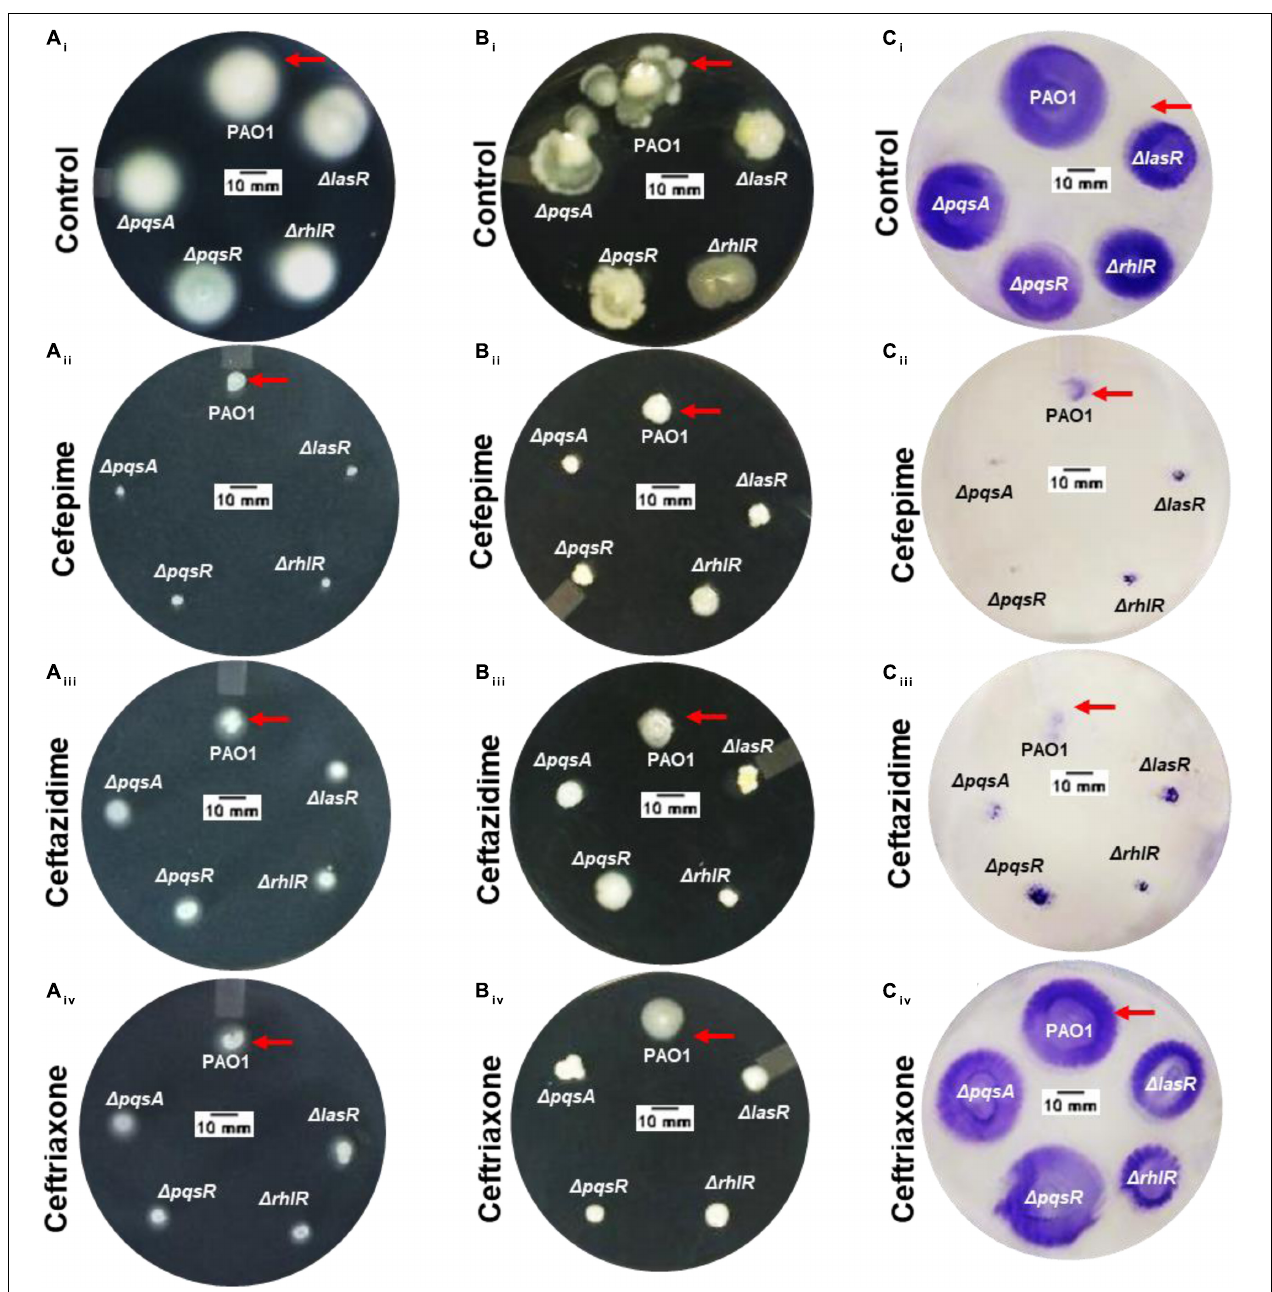
FIGURE 3 | Effect of cephalosporins on motility phenotypes of Pseudomonas aeruginosa PAO1 and its isogenic QS mutant strains. Image showing the comparative zone of swimming (A i ) , swarming (B i ) , and twitching motility (C i ) of PAO1 and its isogenic QS mutant strains ( (cid:49) lasR, (cid:49) rhlR, (cid:49) pqsA, and (cid:49) pqsR ). Image of the media plate showing the effect of CP (A ii ,B ii ,C ii ) , CF (A iii ,B iii ,C iii ) , and CT (A iv ,B iv ,C iv ) , on swimming, swarming, and twitching motility zones of P. aeruginosa PAO1 (Scale bar = 10 mm).